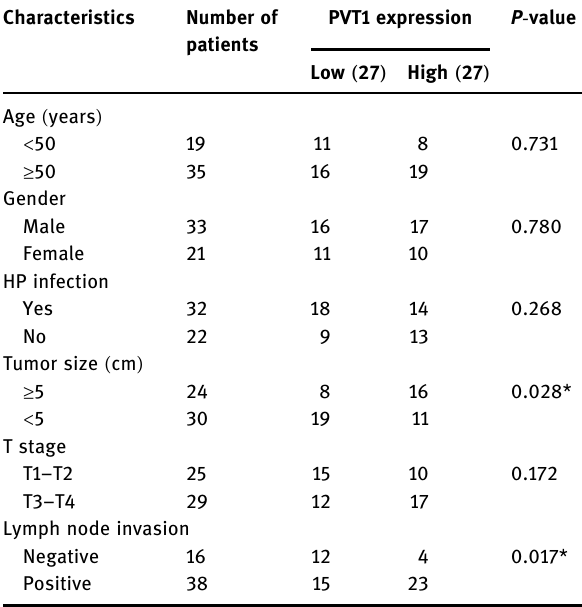
Table 1: Relationship between PVT1 expression and clinicopatho - logical characteristics of GC patients